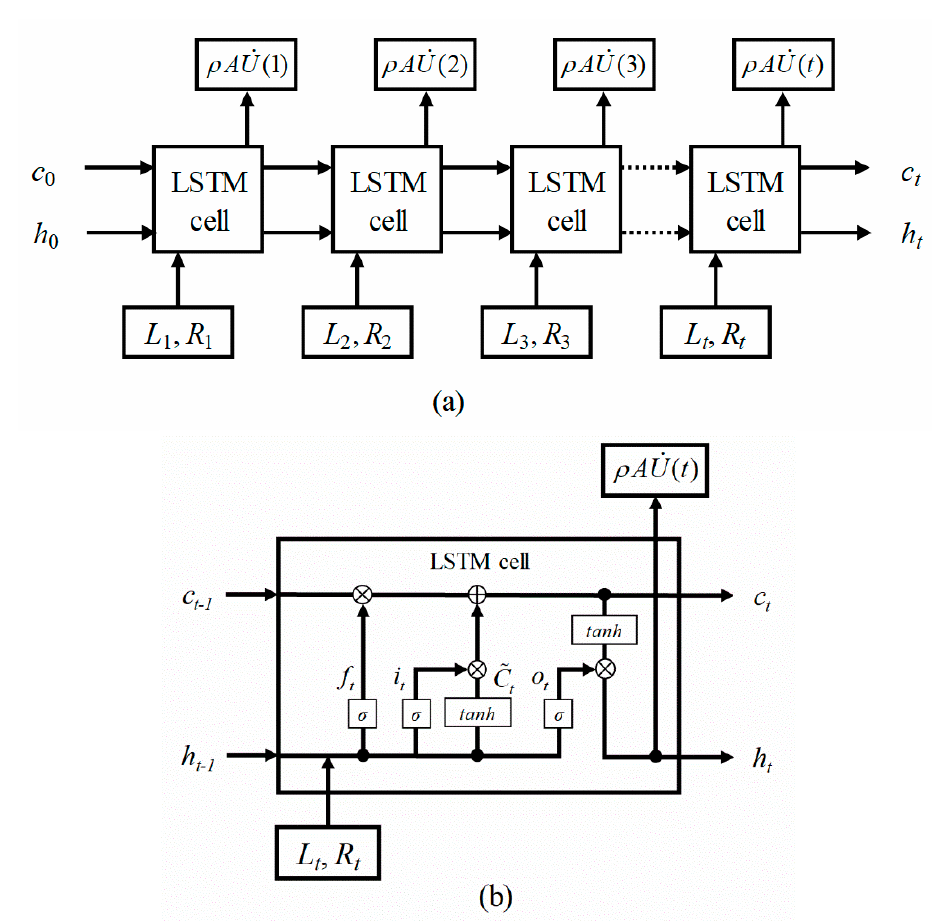
Figure 6. ( a ) LSTM neural network used to predict the transient flow rates with the vibration responses (level and roughness) as the input features, and the measured flow rate as the output features. ( b ) Diagram structure of LSTM cell state.